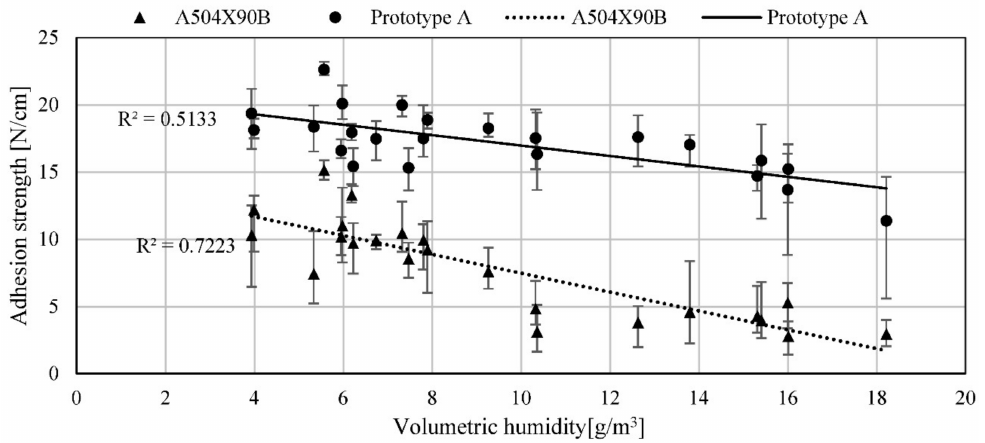
Figure 1. Relationship between volumetric humidity and adhesion strength.